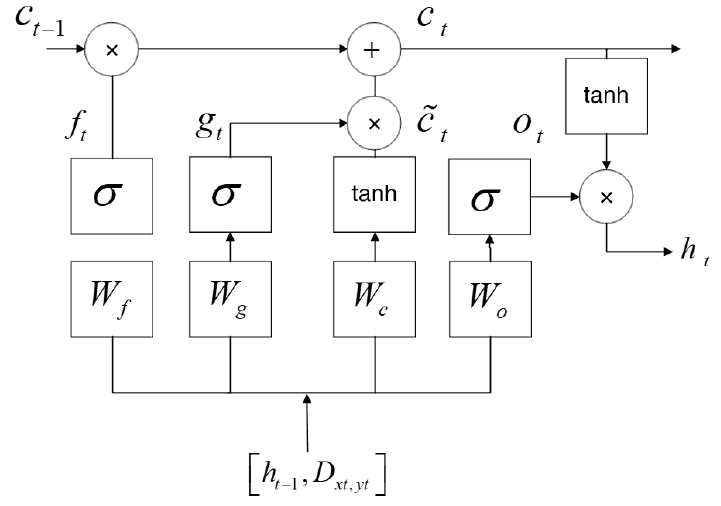
Figure 7. Forward propagation of long short-term memory